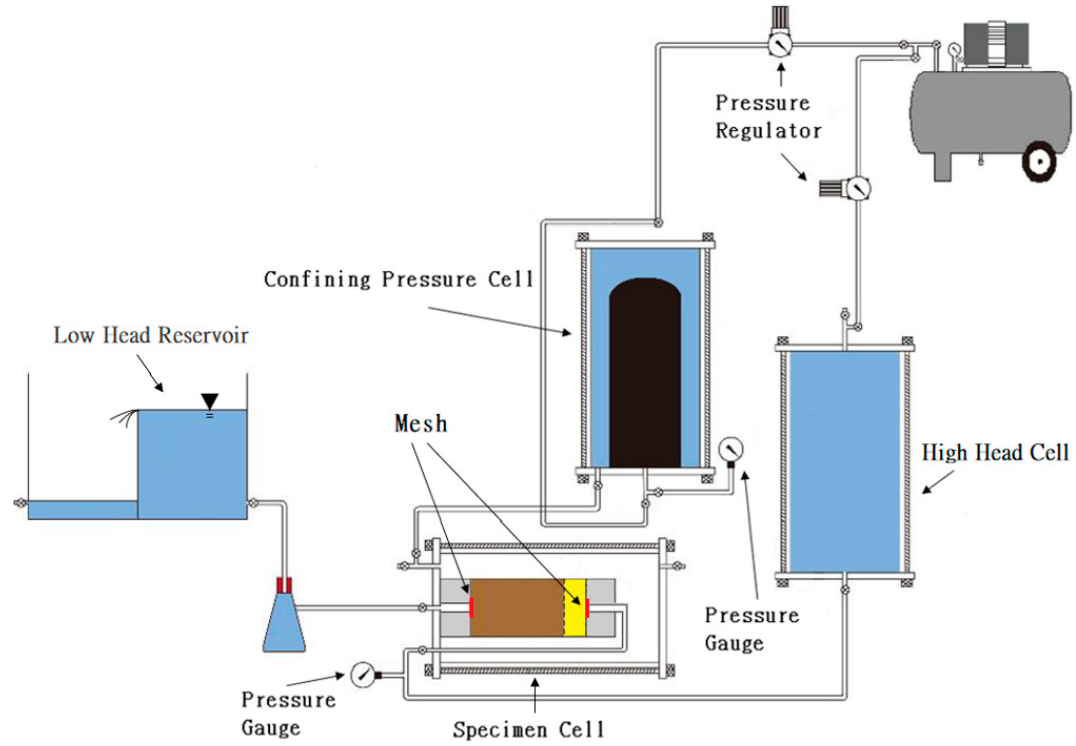
Figure 1. Schematic of the test apparatus.